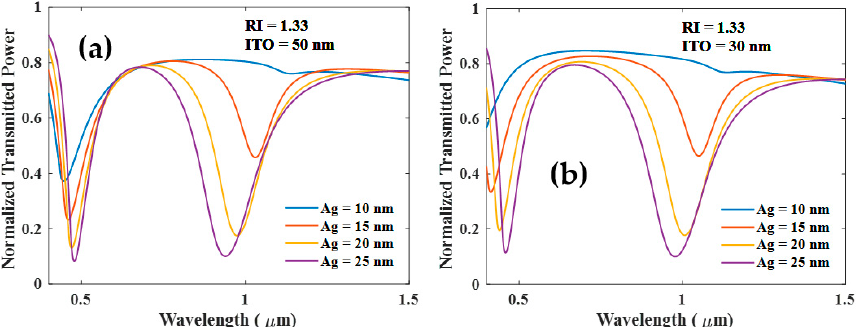
Figure 3. Normalized transmission spectra of sensing probe for various thicknesses of the Ag and ( a ) ITO (50 nm) ( b ) ITO (30 nm) and RI of the surrounding medium is 1.33.